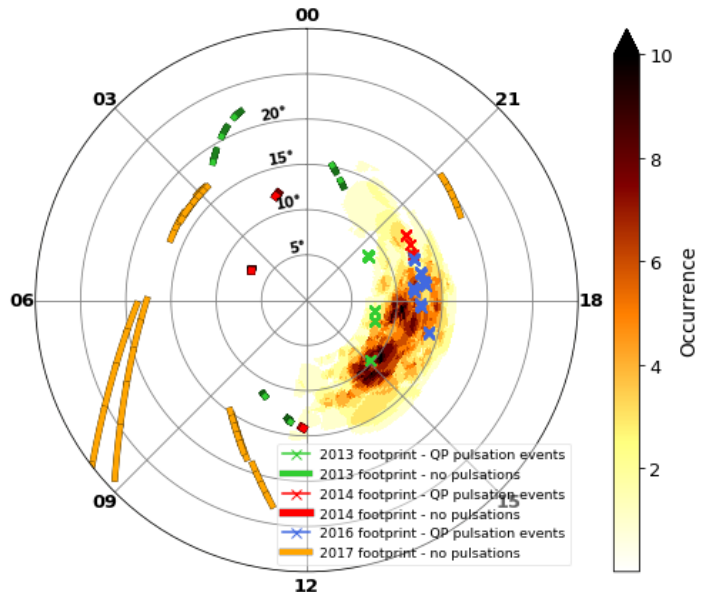
Figure 5. Summary footprint of Cassini orbiter in flash sequences identified in HST images from 2013–2017 plotted on top of “heat map” of transient flashing events. The polar projection extracts latitude from 90 to 60 ◦ (i.e., 0 to 30 ◦ colatitude) with a step of 5 ◦ . The colour scale of the “heat map” encodes the number of occurrences from plain white to dark orange with the highest value 10. The year every colour stands for is listed in lower right corner, with crosses representing the detected QP pulsations (green: 2013-110, 2013-138, 2013-139, red: 2014-100, blue: 2016-181,